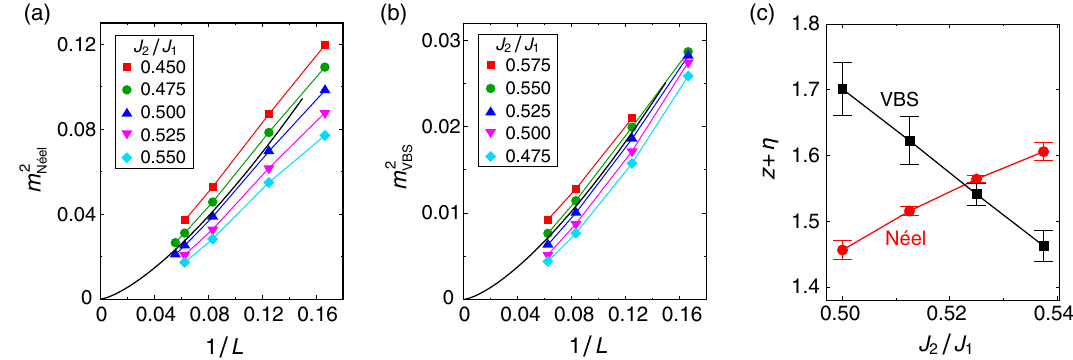
FIG. 9. Size dependence of the squared order parameters for (a) N`eel-AFM and (b) VBS. The solid black curves in (a) and (b) are the expected size dependence at the critical point m 2 ∝ L − ð z þ η Þ with z þ η estimated by the finite-size scaling analysis shown in Fig. 8. The critical points are estimated from the analyses based on the correlation ratio and the level spectroscopy. (c) J 2 dependence of the power- law exponent z þ η in the QSL phase obtained by fitting the size dependence of m 2 for L ¼ 8 , 12, 16 with a form m 2 ¼ AL − ð z þ η Þ ( A is a